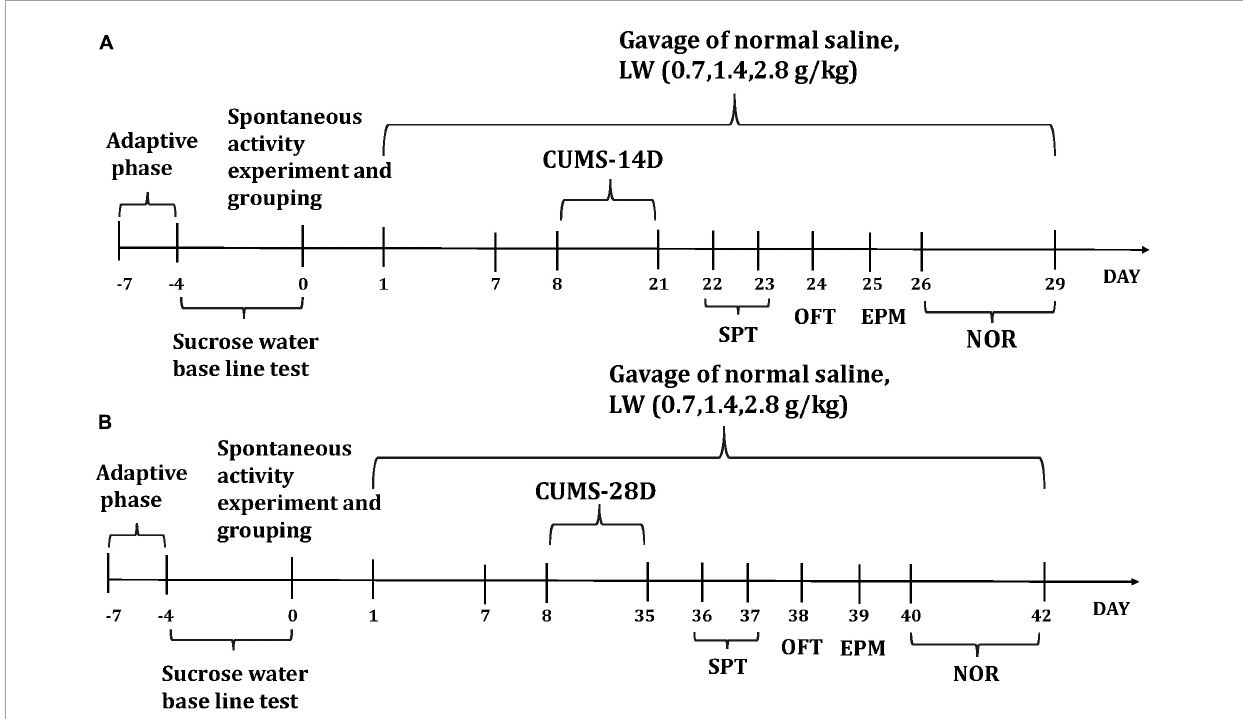
FIGURE1 The experimental timeline and the effects of CUMS on mice. The dosage and days of intragastric administration and the specific time arrangement of each behavior after the end of CUMS-14D (A) , CUMS-28D (B) .